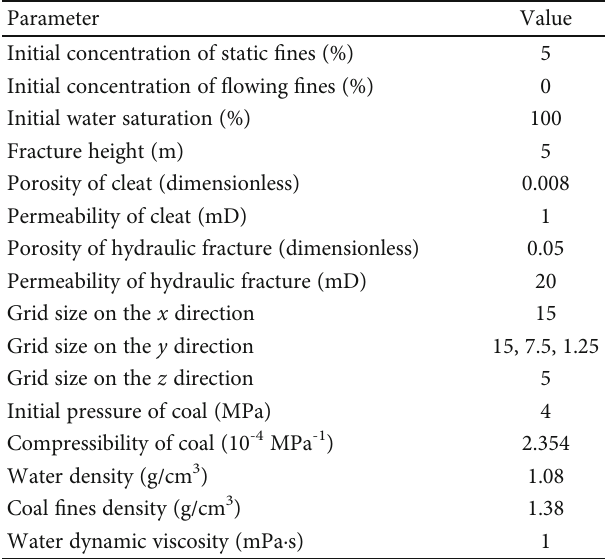
Table 1: Basic parameters of the